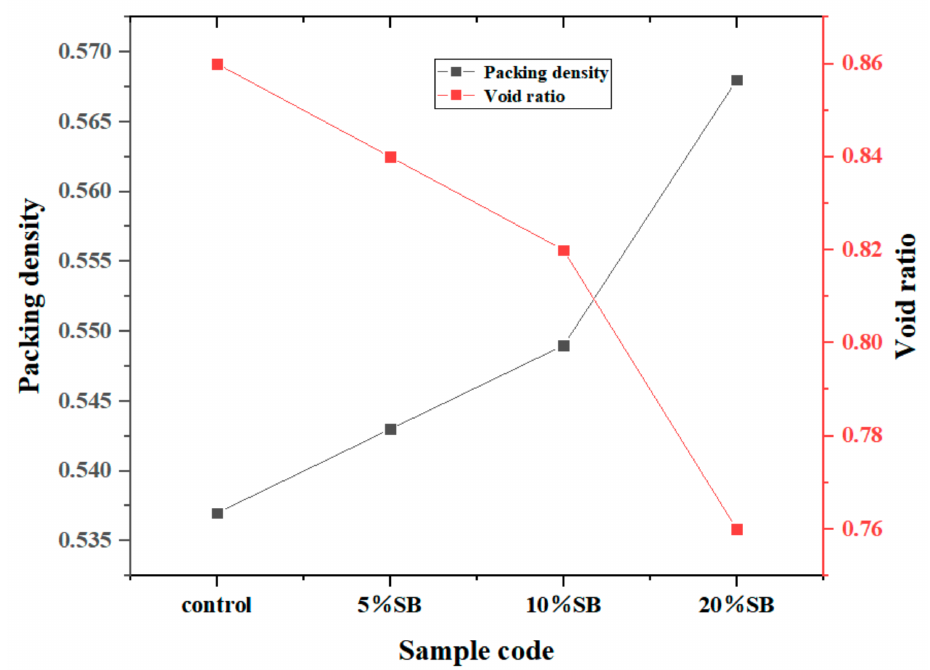
Figure 3. Variations of the void ratio and packing density at different SB